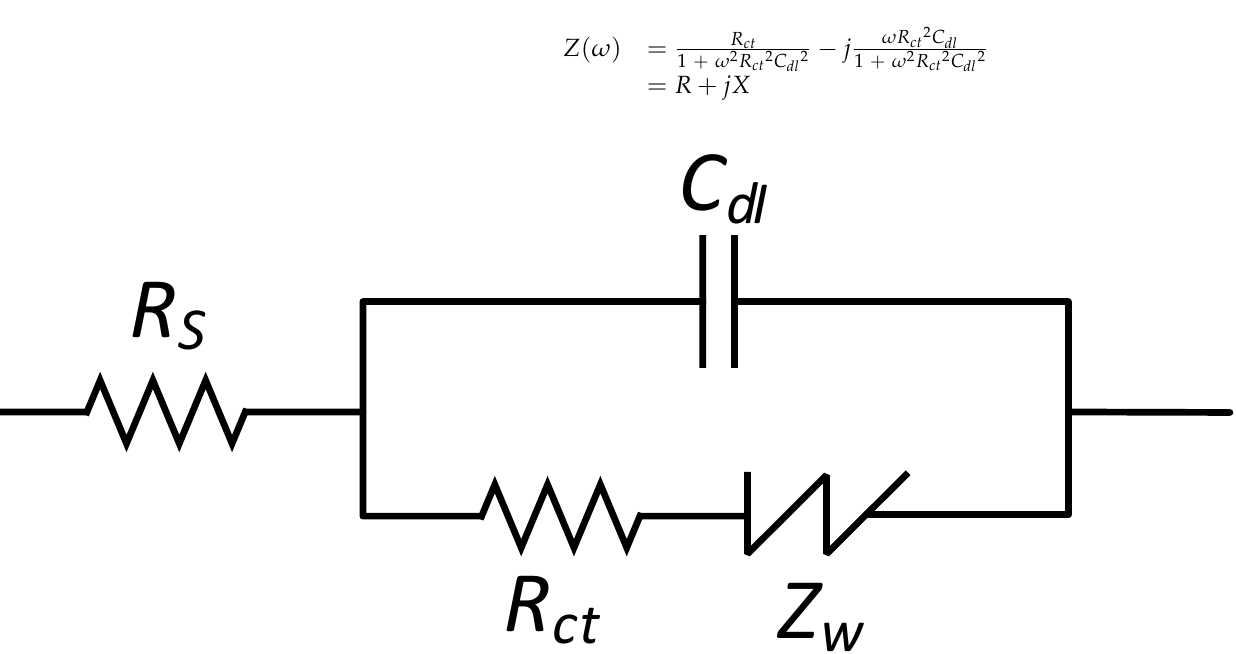
Figure 3. The Randles and Ershler circuit model. R S : solution resistance; Z W : diffusion efficiency, C dl : electric capacity, R ct : charge transfer resistance on the electrode.